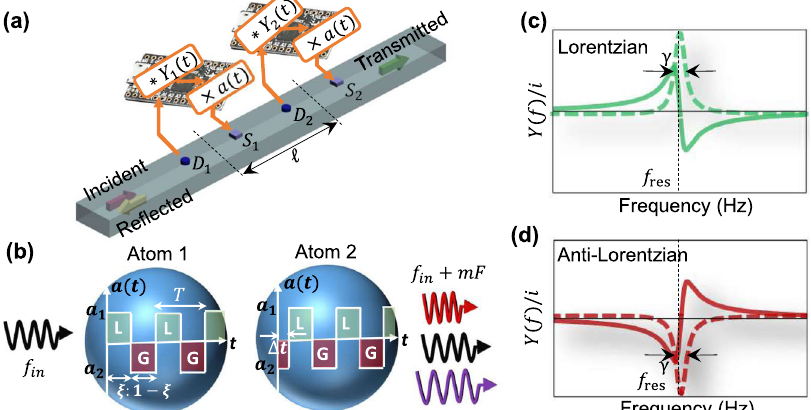
Fig. 1 Non-Hermitian space − time varying metamaterial platform. a Schematic of the space − time varying metamaterials platform in a 1D acoustic waveguide. The microphones (speakers) for the two atoms are labeled as D 1 , D 2 ( S 1 ; S 2 ). b A square-wave amplitude modulation a ð t Þ is applied on the meta-atoms with a modulation period T and duty-cycle ξ . An additional modulation time delay Δ t can be applied on atom 2. The convolution kernel Y ð f Þ = i for a lossy meta-atom ( c ) and active meta-atom ( d ), corresponds to the Lorentzian and anti-Lorentzian line-shape respectively. Real and imaginary parts are plotted in solid and dashed lines